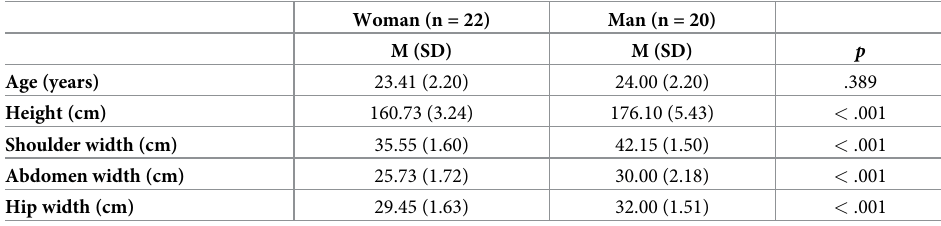
Table 2. Participants’ age and body sizes